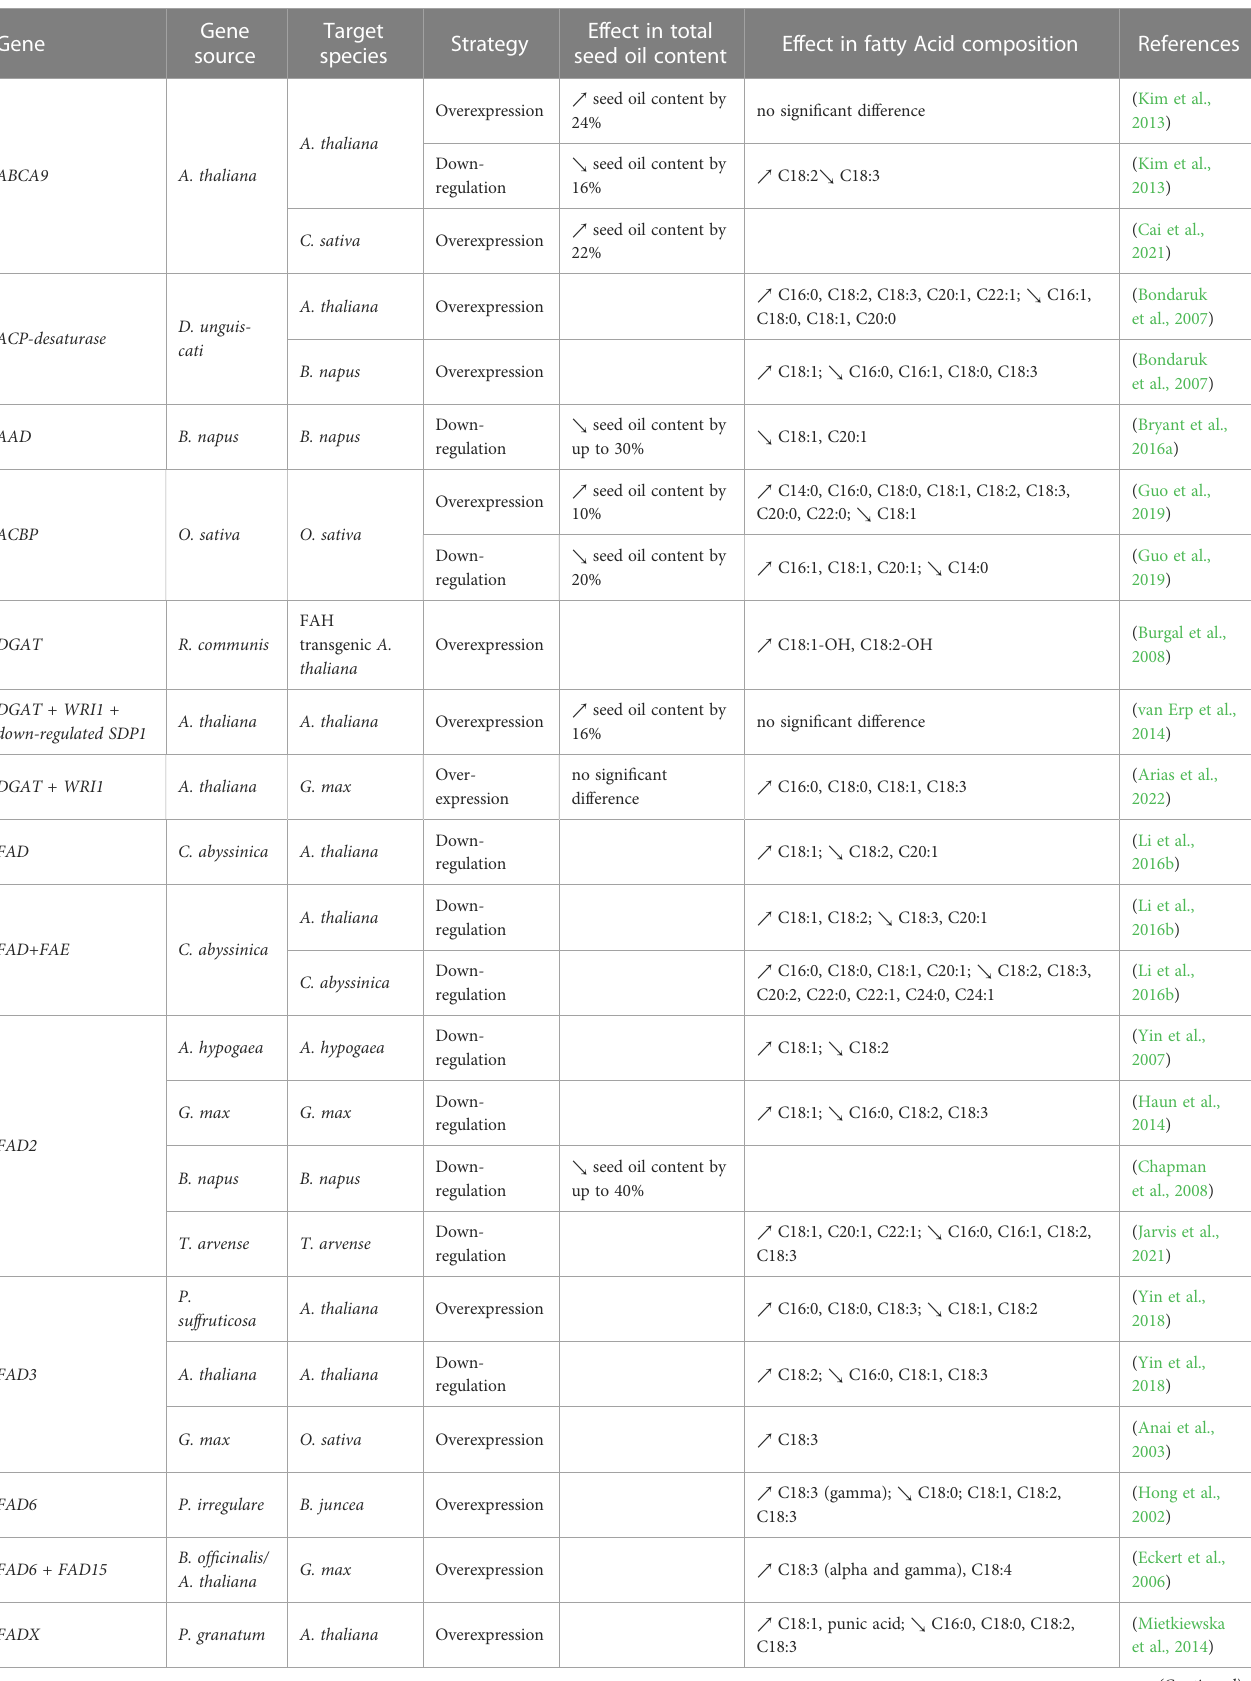
TABLE 5 List of “ pull ” genes manipulated to enhance oil yield and/or change FA composition in seeds.